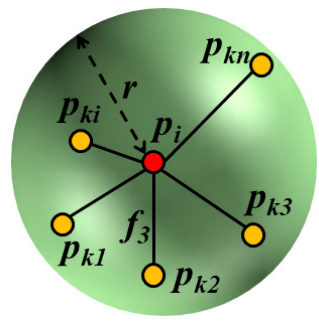
f . p is the key point, r is the radius neighborhood Figure 3. The diagram of distance parameter Figure 3. The diagram of distance parameter f 3 . p i is the key point, r is the radius neighborhood of 3 i p is the point in the neighborhood sphere with the radius r . of the key point, the key point, p ki is the point in the neighborhood sphere with the radius r ki